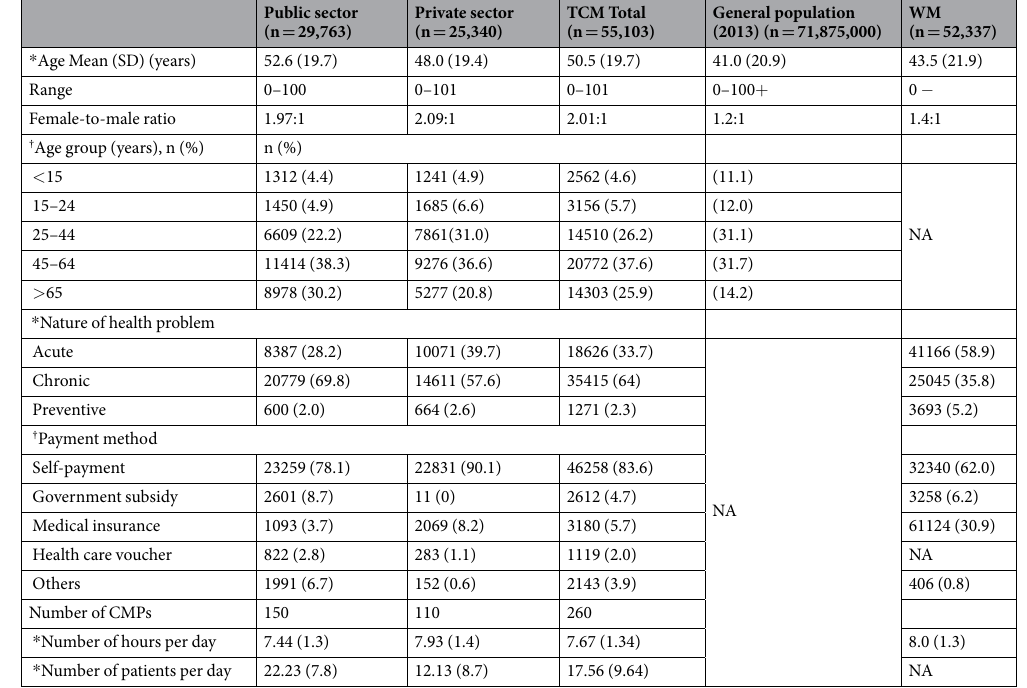
Table 2. Characteristics of patients under care of Chinese medicine practitioners in the private and public sectors. TCM, traditional Chinese medicine; WM, Western medicine; SD, standard deviation; CMP, Chinese medicine practitioners; NA, not available. Note: * p < 0.05 between public vs private sectors; TCM vs WM samples by independent sample t-test or chi-square test. † p < 0.05 between public and private sectors by independent sample t-test or chi-square